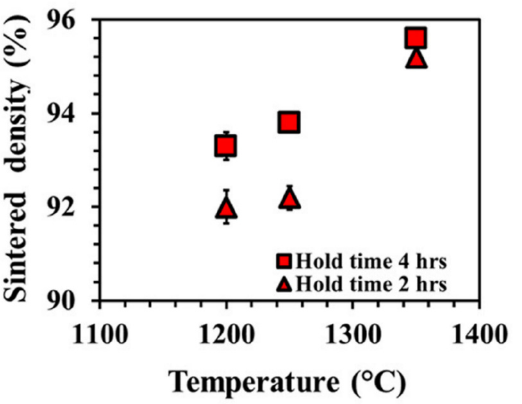
Figure 13. Relative sintered density of Ti-6Al-4V fabricated by metal MEX process sintered using varied sintering temperature and time, demonstrating the dependence of relative sintered density on the sintering temperature and time (Reprinted with permission from [78]. Copyright 2021, Powder Technology, Elsevier).